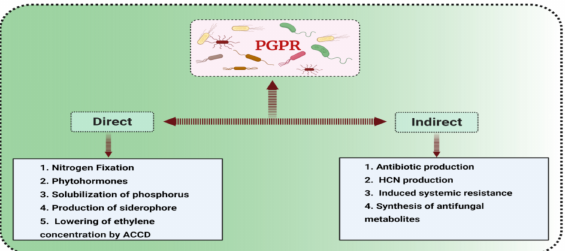
Figure 1. PGP traits of bacteria. Traits that have direct effects and those that have indirect effects (suppression of diseases) on plant growth are shown in the figure.